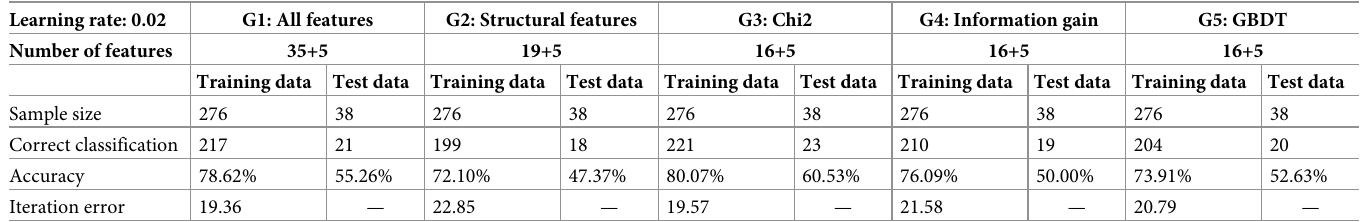
Table 5. Training to optimal